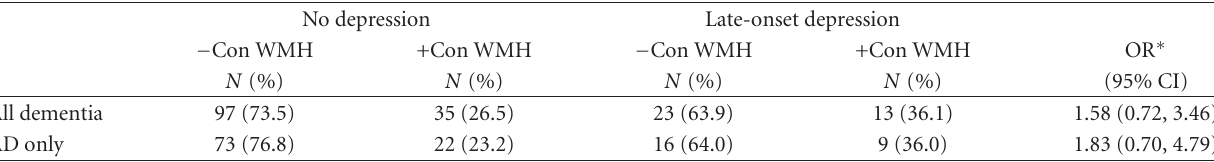
Table 3: Risk of confluent frontal lobe deep white matter hypodensities in late-onset depression compared with No depression for all dementia and alzheimer’s disease.